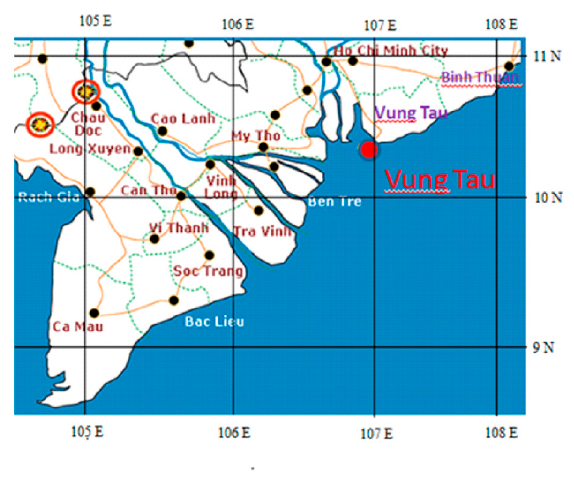
Figure 2. The study area and location of Vung Tau station.